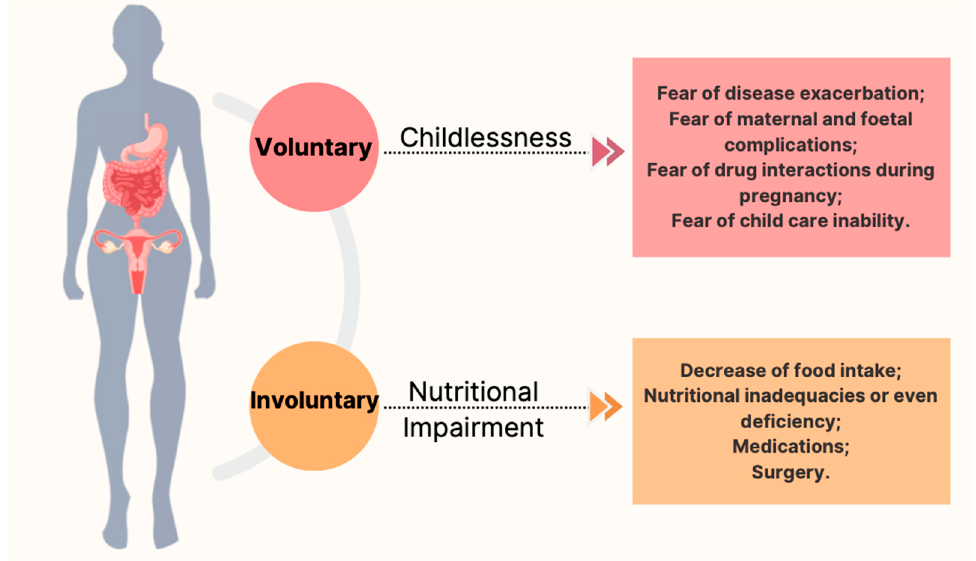
Figure 1. The most common causes of voluntarily and involuntarily infertility in women with CD. The role of diet and nutrition education in supporting wellbeing outcome and fertility in women is well-known [20,21]; however, despite evidence, no effective efforts have been made to tailor specific interventions in women affected by